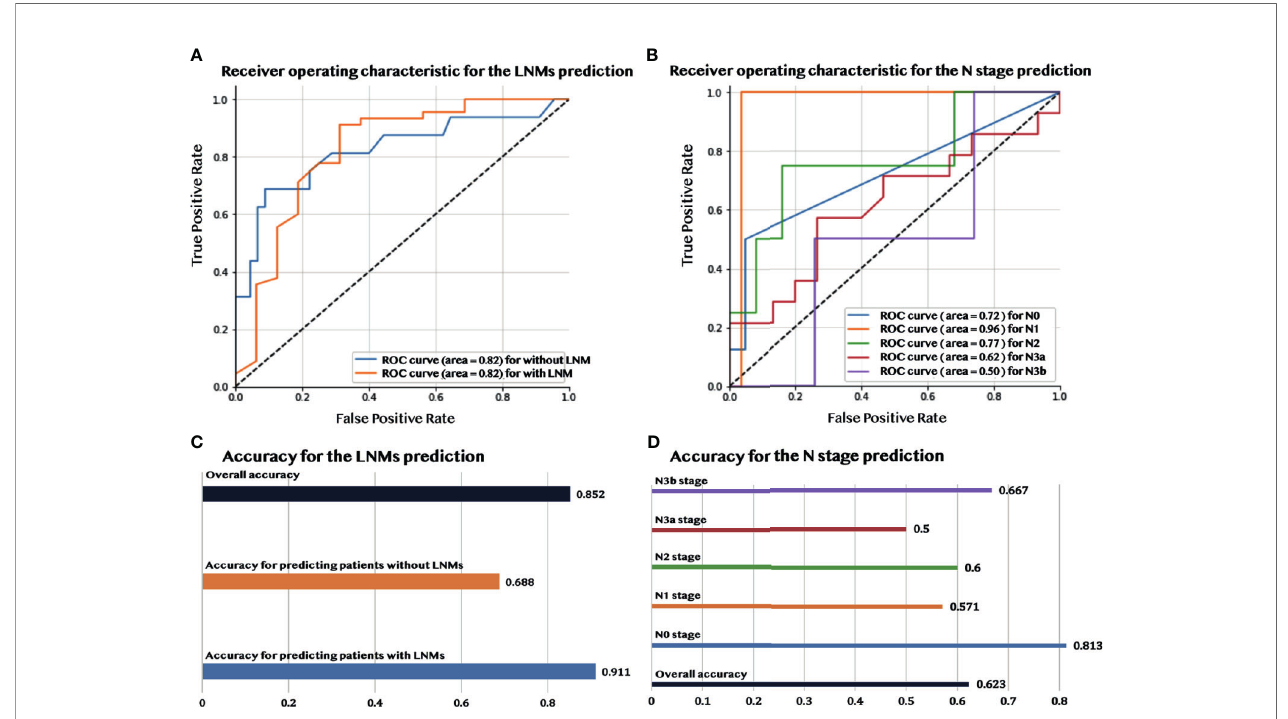
FIGURE 3 | The performance of predicting LNMs and the N stage. (A) The AUC curve for predicting LNMs. (B) The AUC curve for predicting the N stage. (C) Accuracy of the prediction of LNMs. (D) Accuracy of the prediction of the N